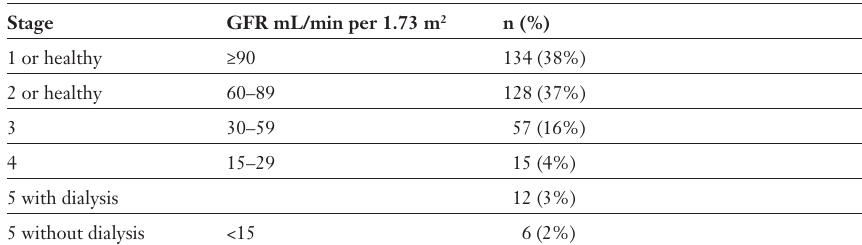
Distribution of renal function (calculated glomerular filtration rate,